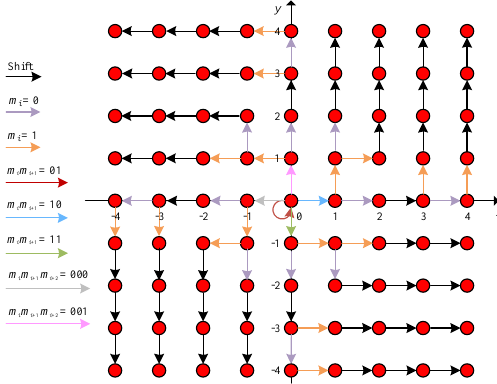
Figure 4. The proposed 2D HS using the ( 0,0 ) coefficient pairs.